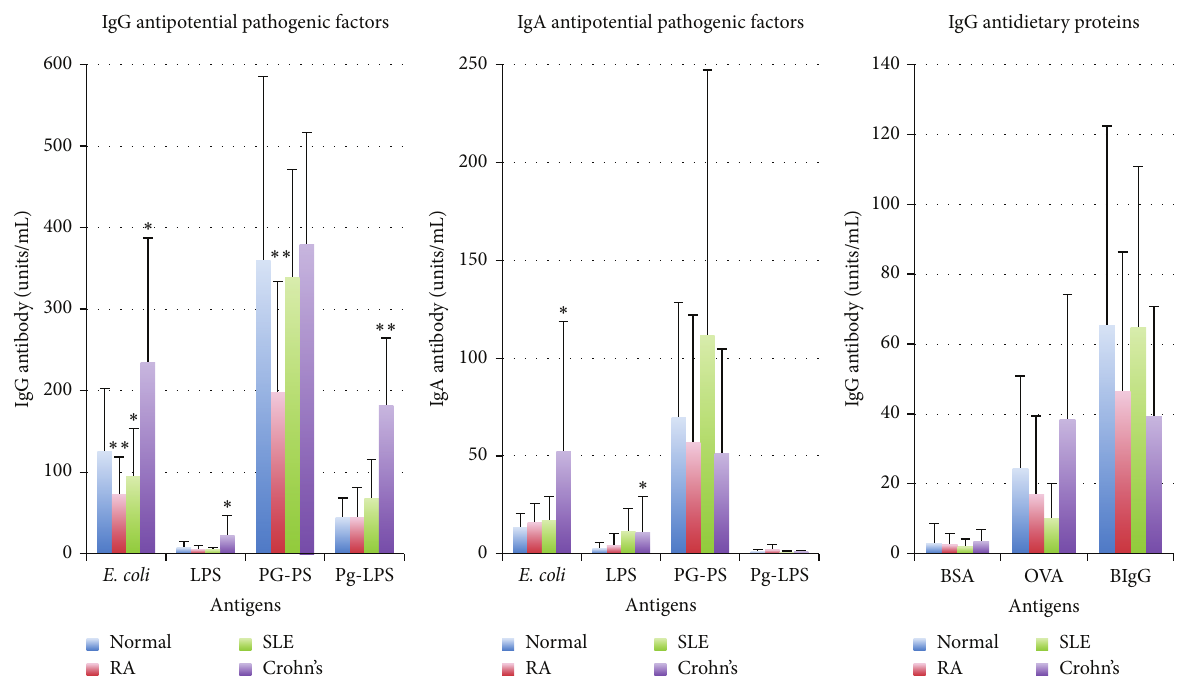
Figure 2: Comparison of IgG and IgA antibody responses to potential pathogenic and nonpathogenic environmental agents between normal controls and patients with RA, SLE, and Crohn’s disease.